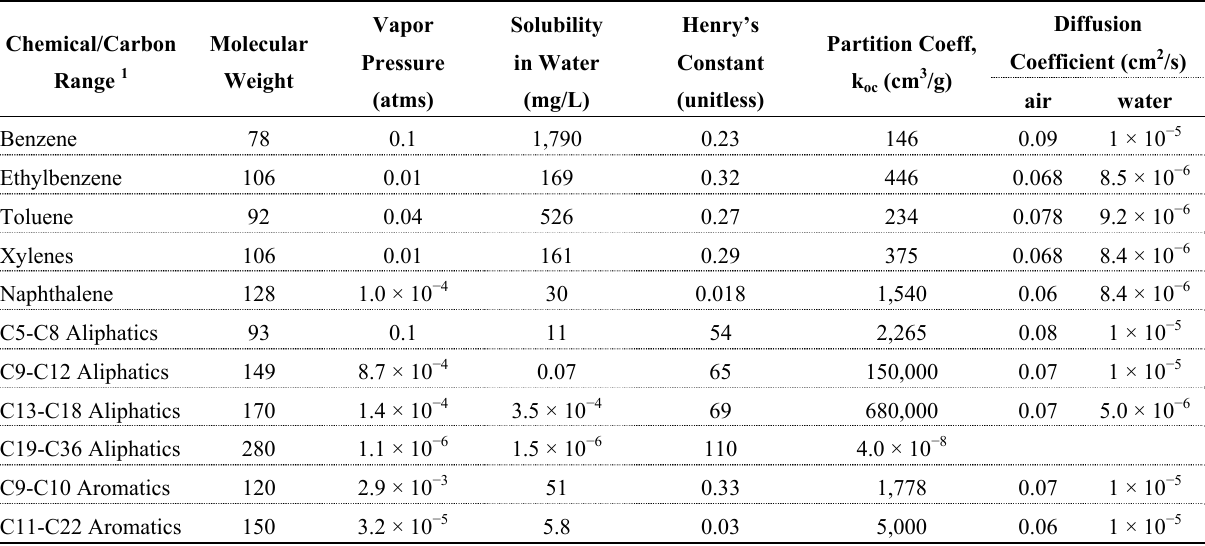
Table 3. Default physiochemical constants for BTEXN and TPH carbon